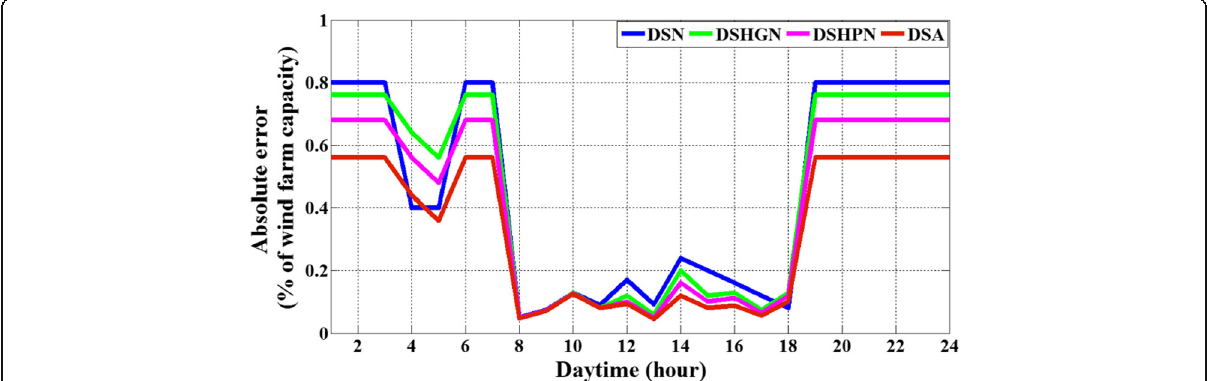
Fig. 11 Normalized absolute values of forecast errors for a fall